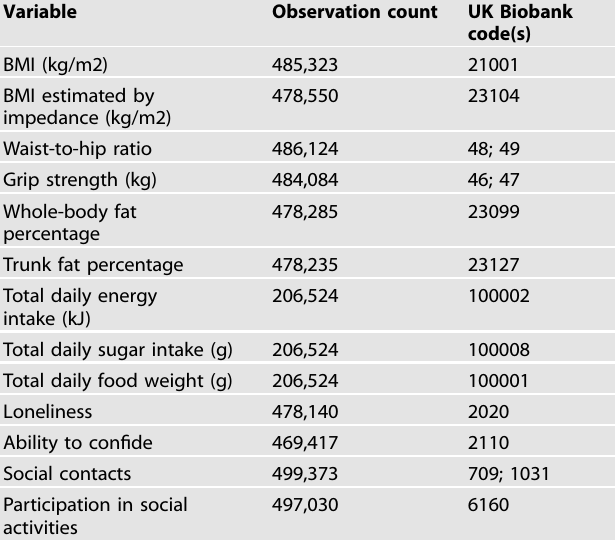
Table 1. Anthropometric and cardiovascular variables.